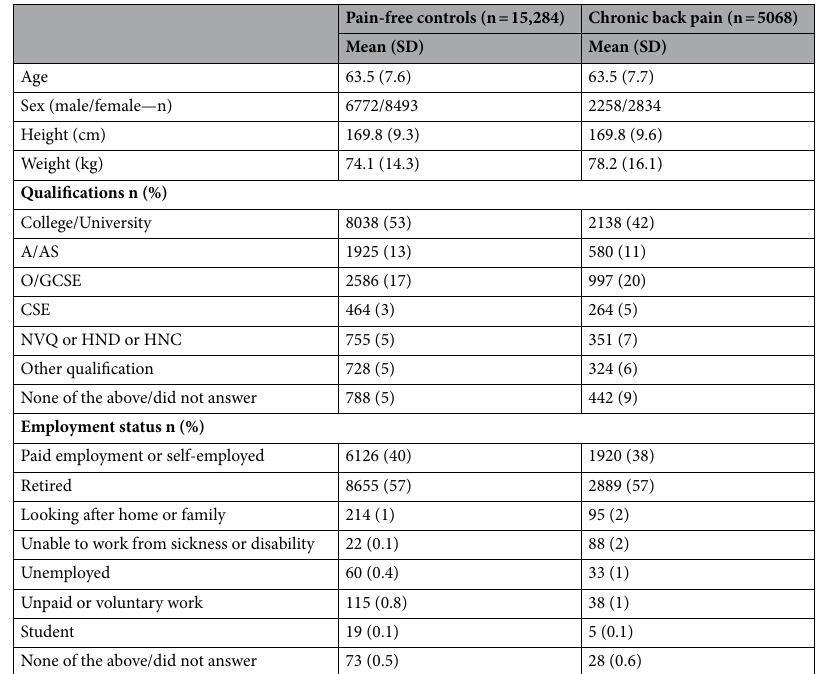
Table 1. Demographics. Data are presented as mean (SD) unless